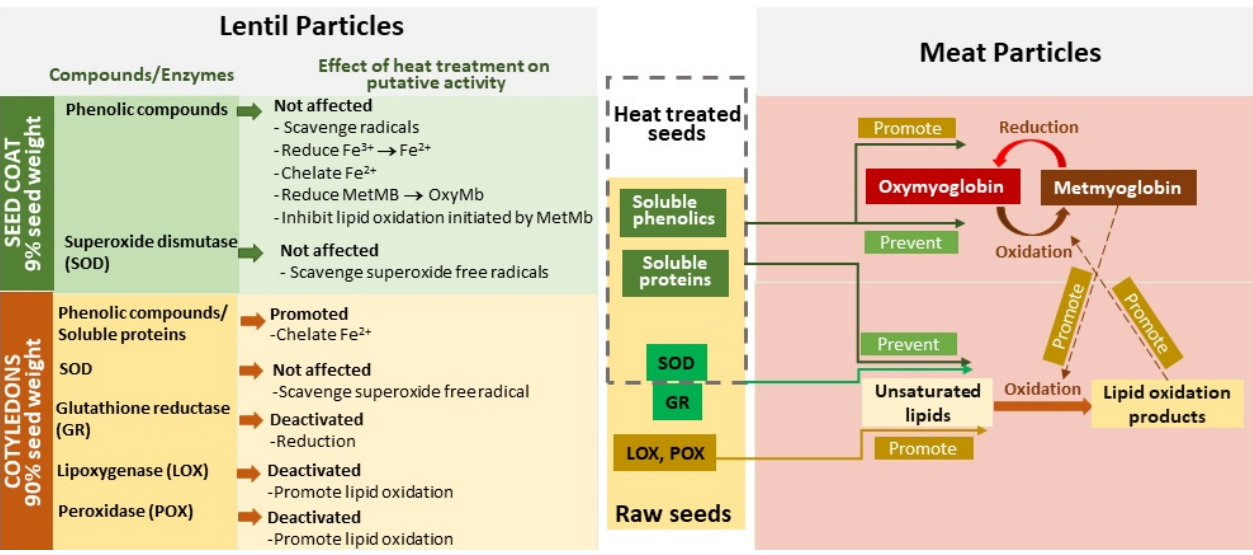
Figure 5. A summary of observed (and postulated) effects of heat treatment ( left ) on phenolic compounds and antioxidative and oxidative enzymes within the lentil seed coat (hull fiber) and cotyledon (dehulled seed flour) separately and their effects on the oxidation of oxymyoglobin and unsaturated lipids in a minced meat particle ( right ). (Adapted with permission from Li [17]). 5.5. IR-Heated Pulse Flours Show Effective Liquid-Holding Properties as a Binder in Meat